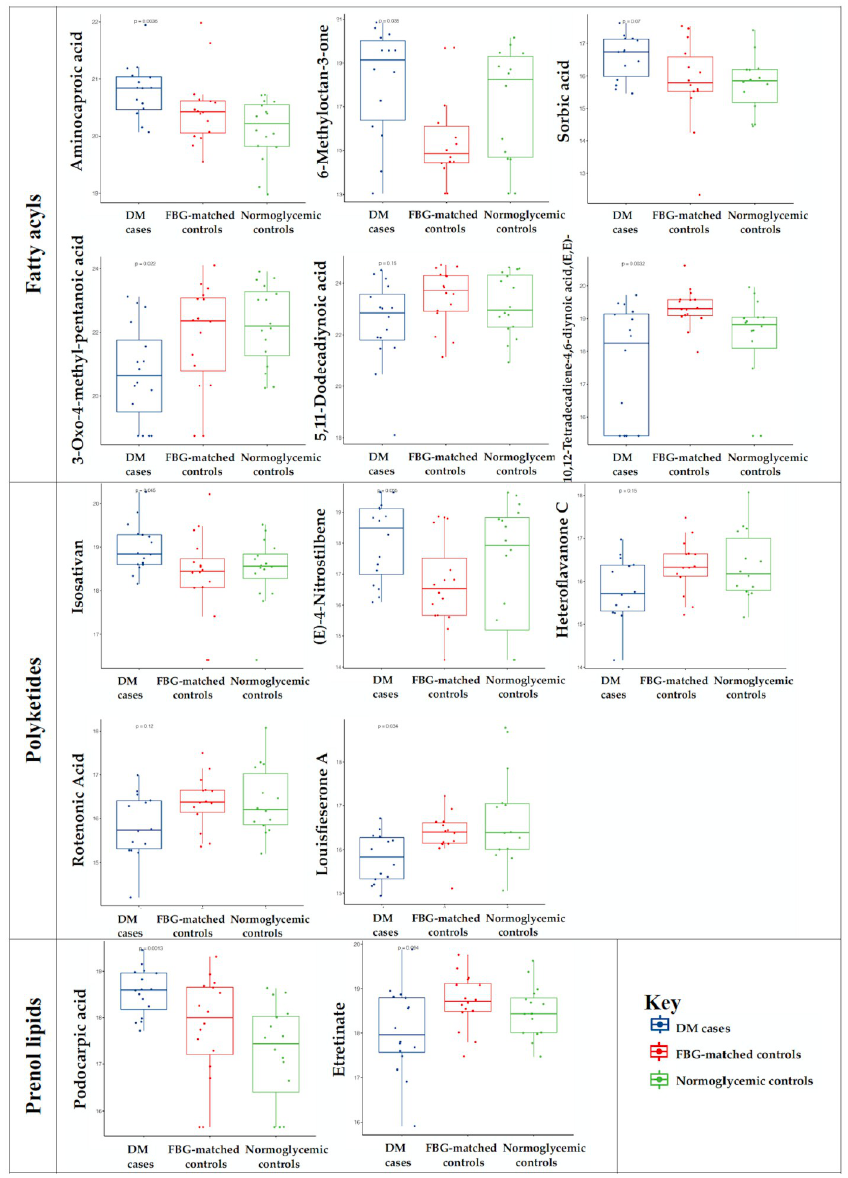
Fig 2. Boxplots of selected features (relative abundances), stratified by DM case and control groups a . a Data subset (e.g. WIHS1 +) specified in Table 3. Abbreviations: DM, diabetes mellitus; FBG, fasting blood